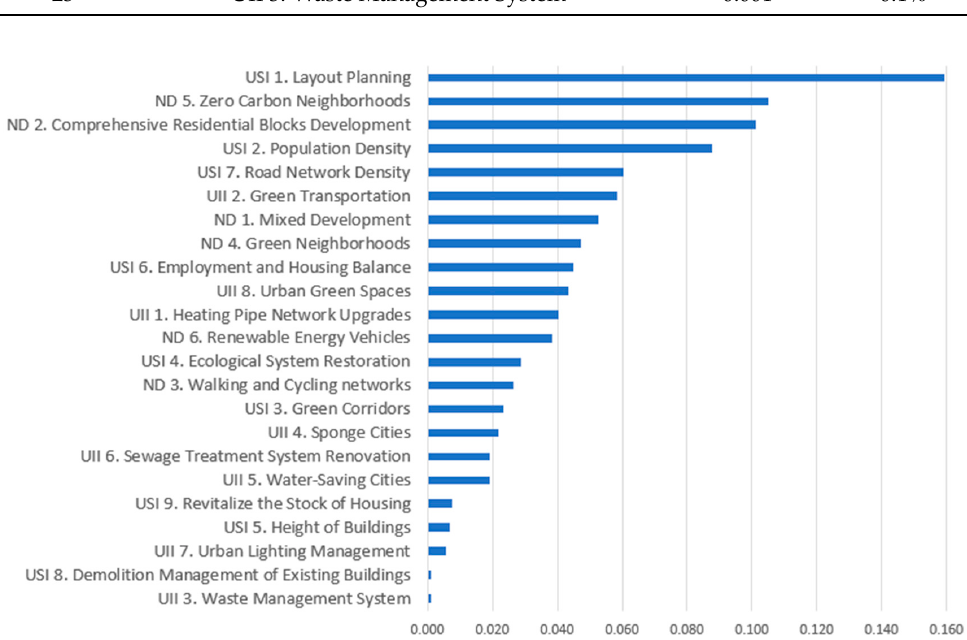
Figure 6. Rankings of indicators.